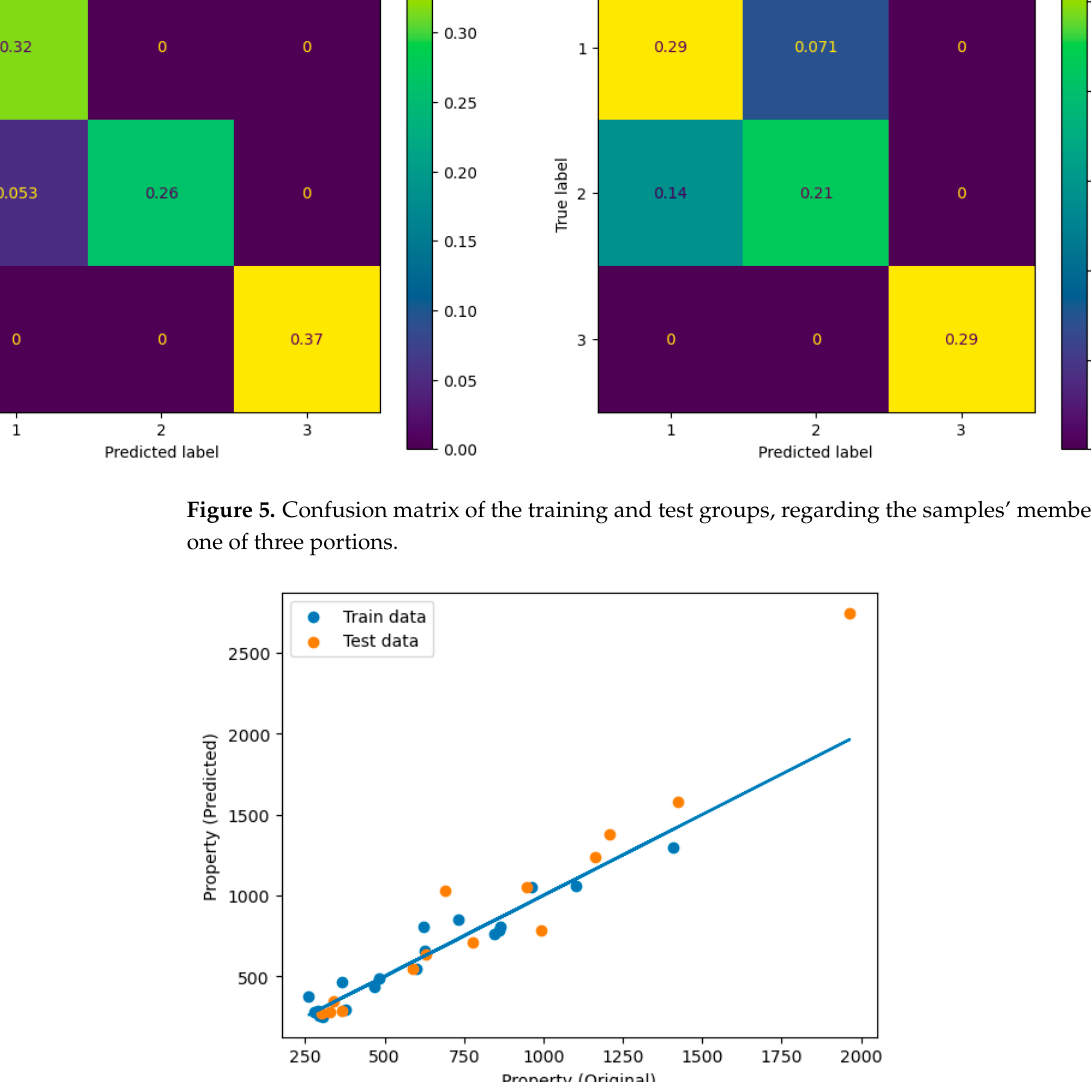
Figure 6. Representation of the results of the regression model created to predict the TPC in different fruit parts.